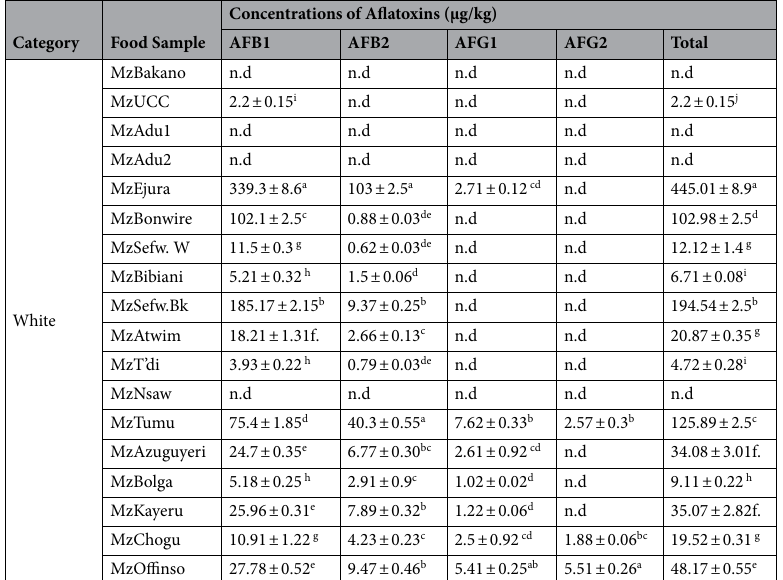
Table 6. Concentration of aflatoxin types in different maize samples from different locations of Ghana. Mean ± Standard Deviation that do not share a letter are significantly different (p > 0.05). n.d not detected.